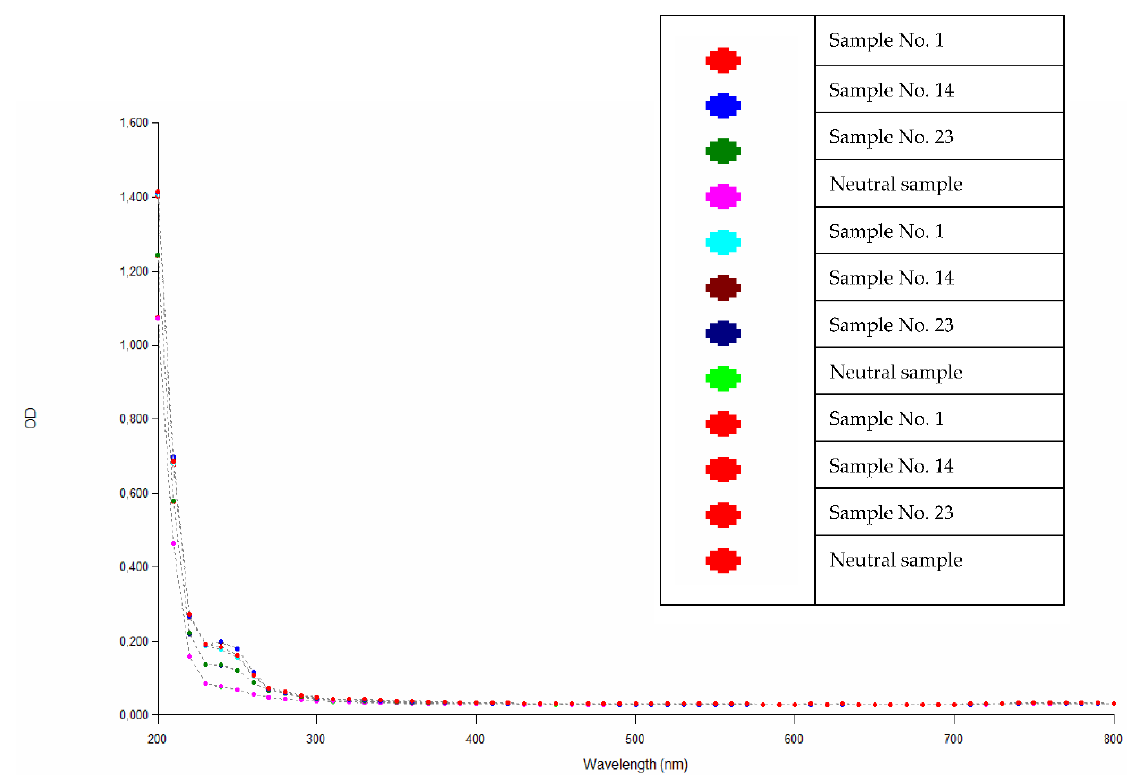
Figure 2. Absorbance values of the extracts of the epoxy